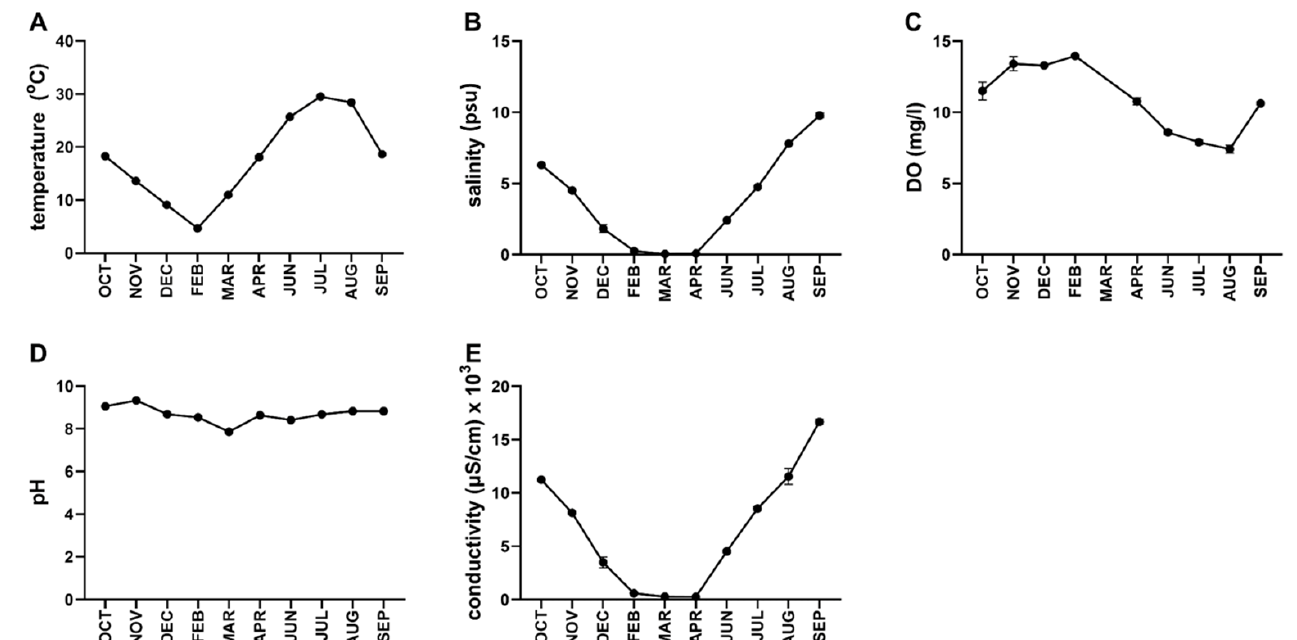
Figure 2. Mean values (±SD) of ( A ) temperature (°C), ( B ) salinity (psu), ( C ) dissolved oxygen (DO, mg/L), ( D ) pH and ( E ) conductivity (μS/cm) in Vistonis Lake (Northern Greece), during the sampling period (October 2014–September 2015). No sampling was conducted in January 2015.